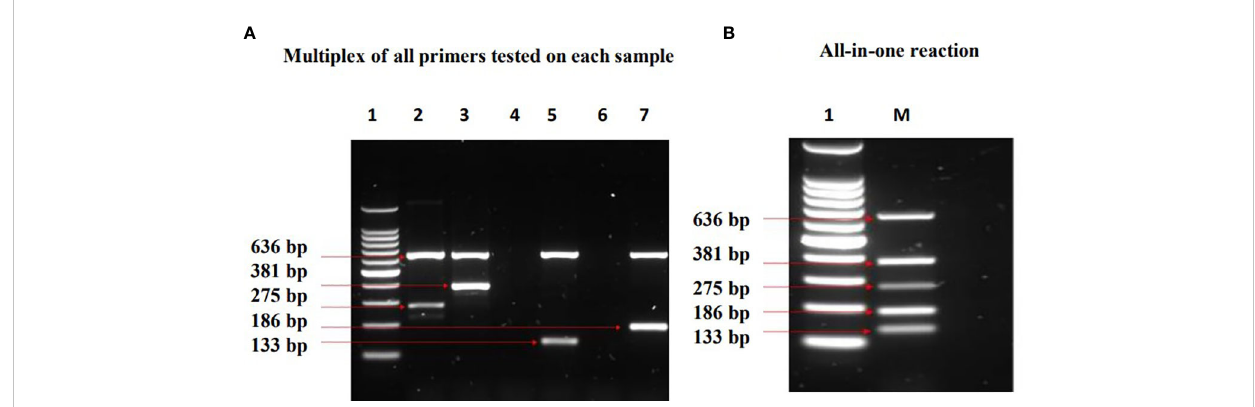
FIGURE 5 Results of Multiplex PCR assays which show identi fi cation of the MTBC lineages investigated. Lane 1= DNA ladder, 2= M. africanum L5, 3= M. africanum L6 (isolate a), 4= E . coli , 5= M. tuberculosis , 6= water, 7= M. bovis , M=mixture of all samples. In (A) multiplex of all primers tested on each DNA sample, two bands were observed in each of the MTBC as expected. The band at 636 bp (positive control) is conserved in all the MTBCs, whereas the other band depicts the respective lineage-speci fi c band. Bands at 275 bp and 381 bp denote M. africanum L5 and L6 speci fi city respectively, while Mtb was represented at 133 bp. M. bovis was identi fi ed at 186 bp. In (B) All in one reaction; the compatibility and speci fi city of the assay was ascertained by combining all primers with mixtures of M. tuberculosis, M. africanum L5 & L6, and M. bovis. The outcome depicts a successful differentiation of the MTBCs without any inhibition.